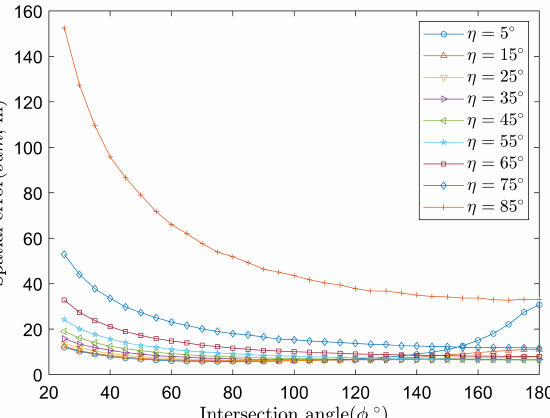
Figure 8. The relationship between spatial error sum and intersection angle φ , elevation angle η